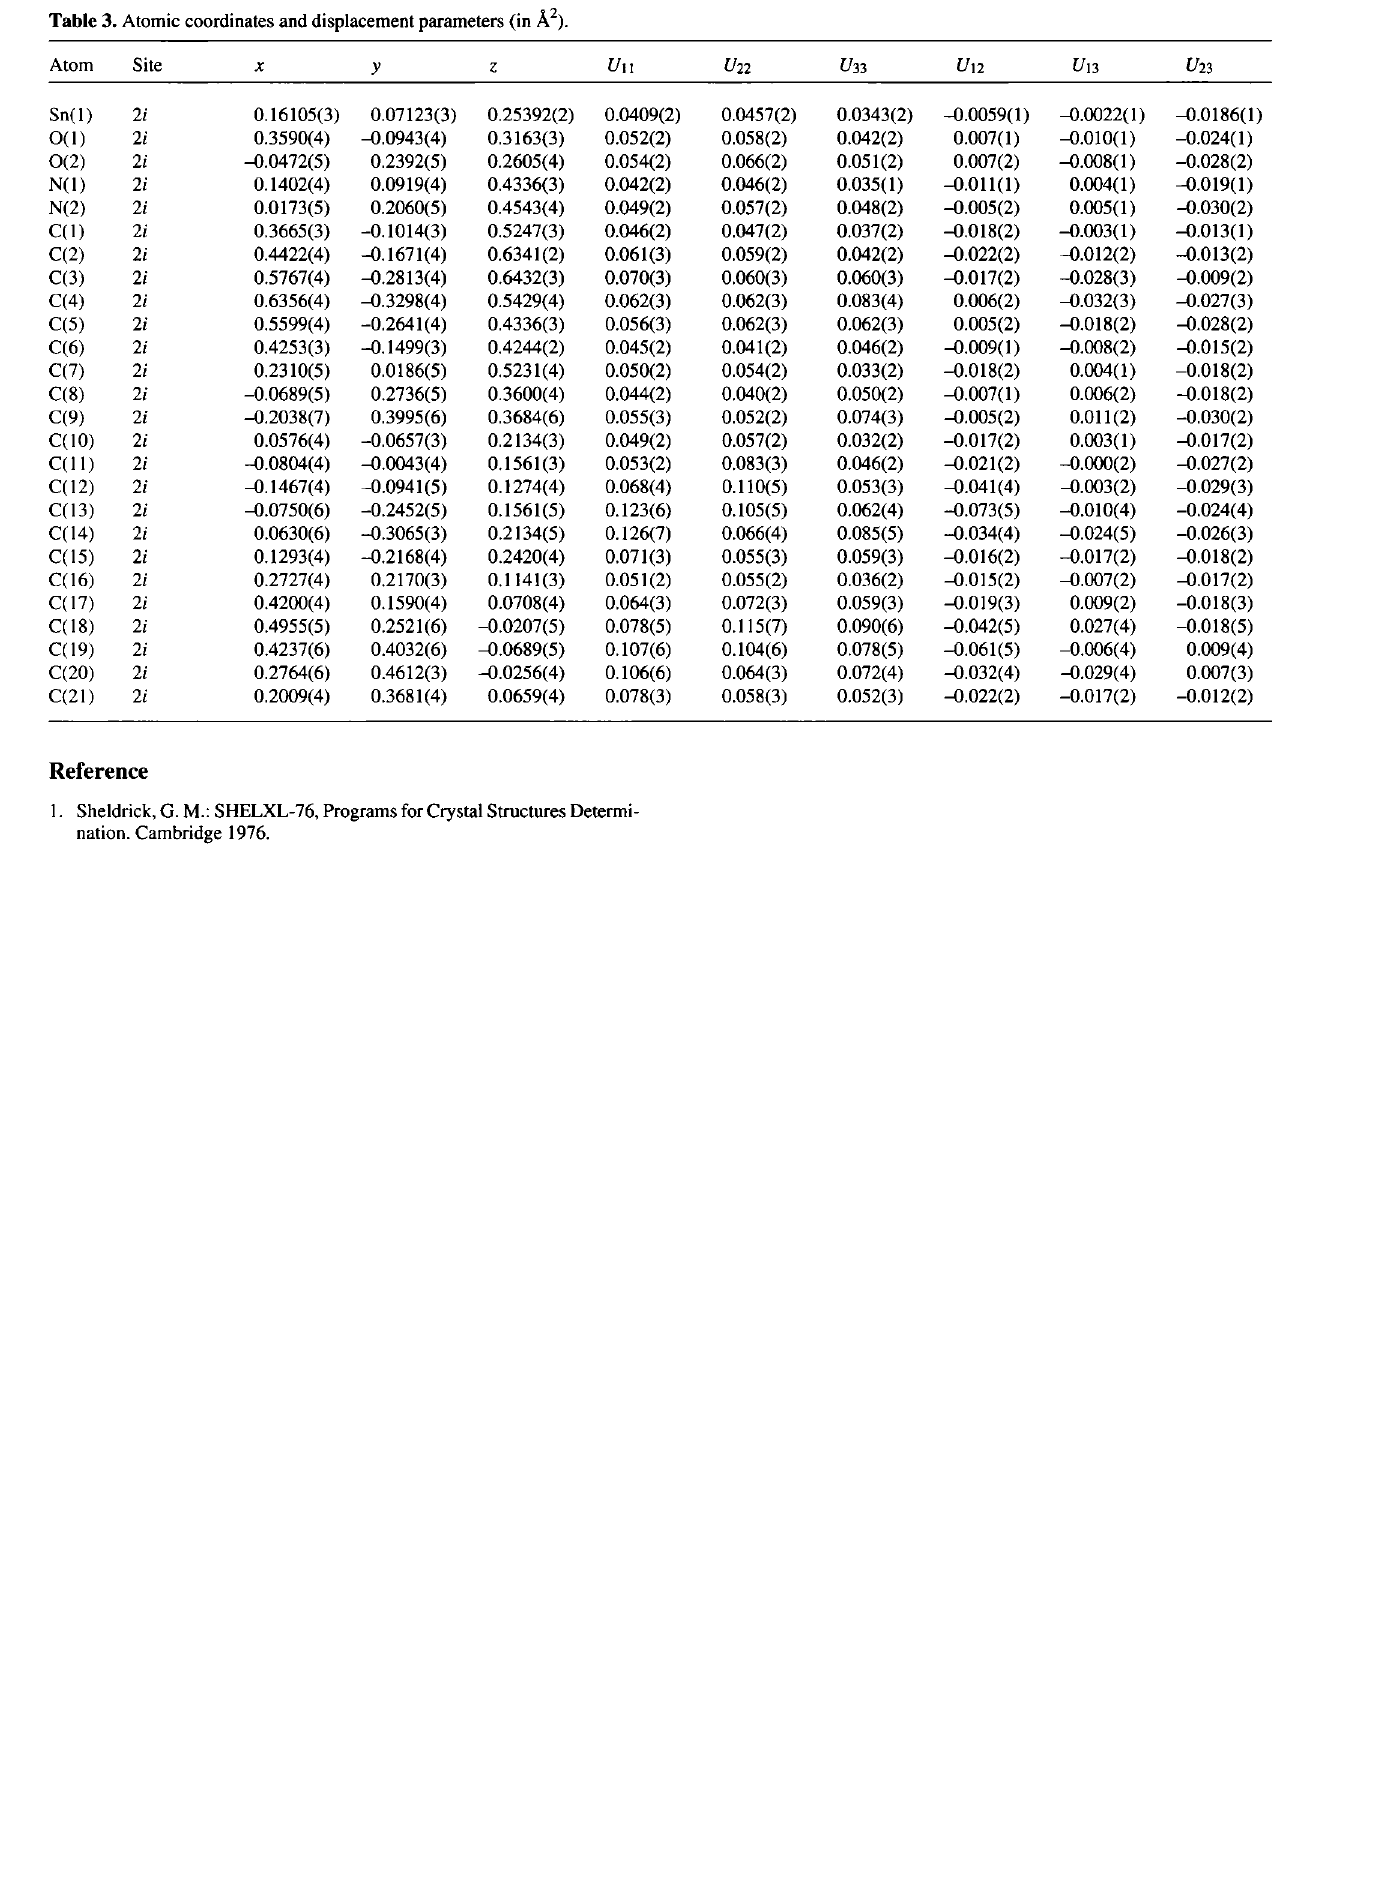
Table 3. Atomic coordinates and displacement parameters (in Ä 2